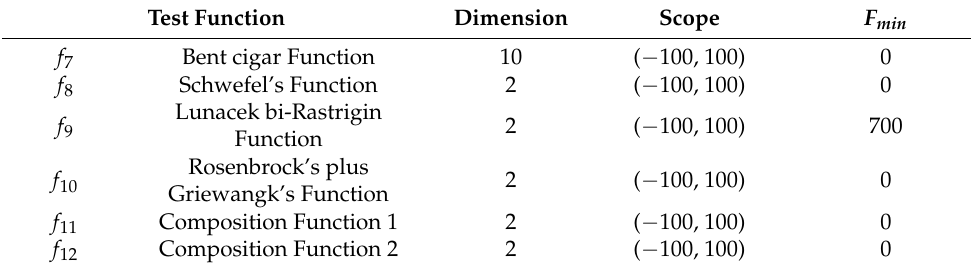
Table 3. CEC-2021 test function.